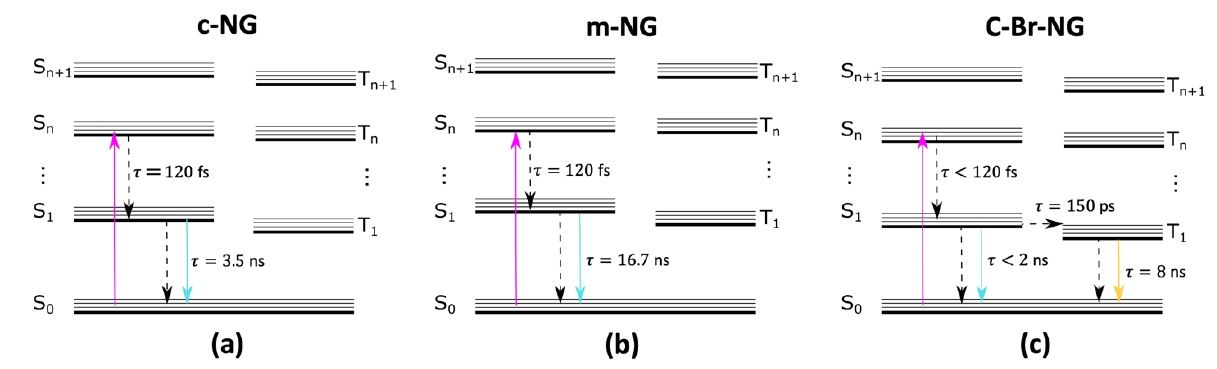
Figure 4. Illustration of the excited-state electronic deactivation pathways and associated timescales of ( a ) c-NG , ( b ) m-NG and ( c ) c-Br-NG .